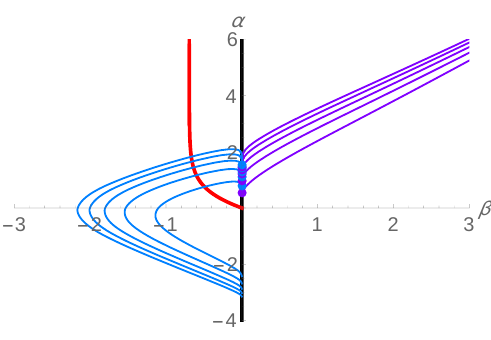
Figure 15 . Location of the (cid:12)rst 10 branches of black ripples (5 ring-like and 5 Saturn-like) in the ( (cid:11); (cid:12) )